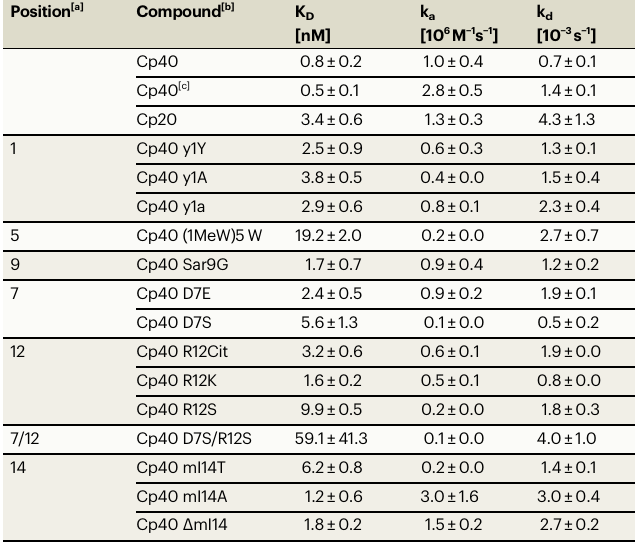
Table 1 | Mutations and corresponding af fi nities and kinetic pro fi les evaluated in the SAR